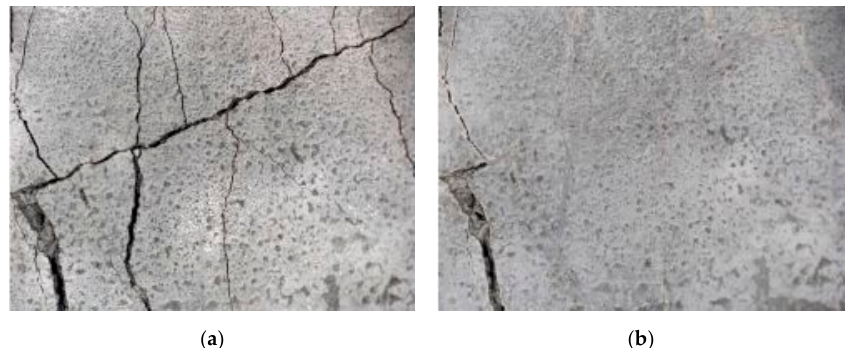
Figure 3. Output from the DigiMicro Profi II microscope. ( a ) First measurement. ( b ) Last